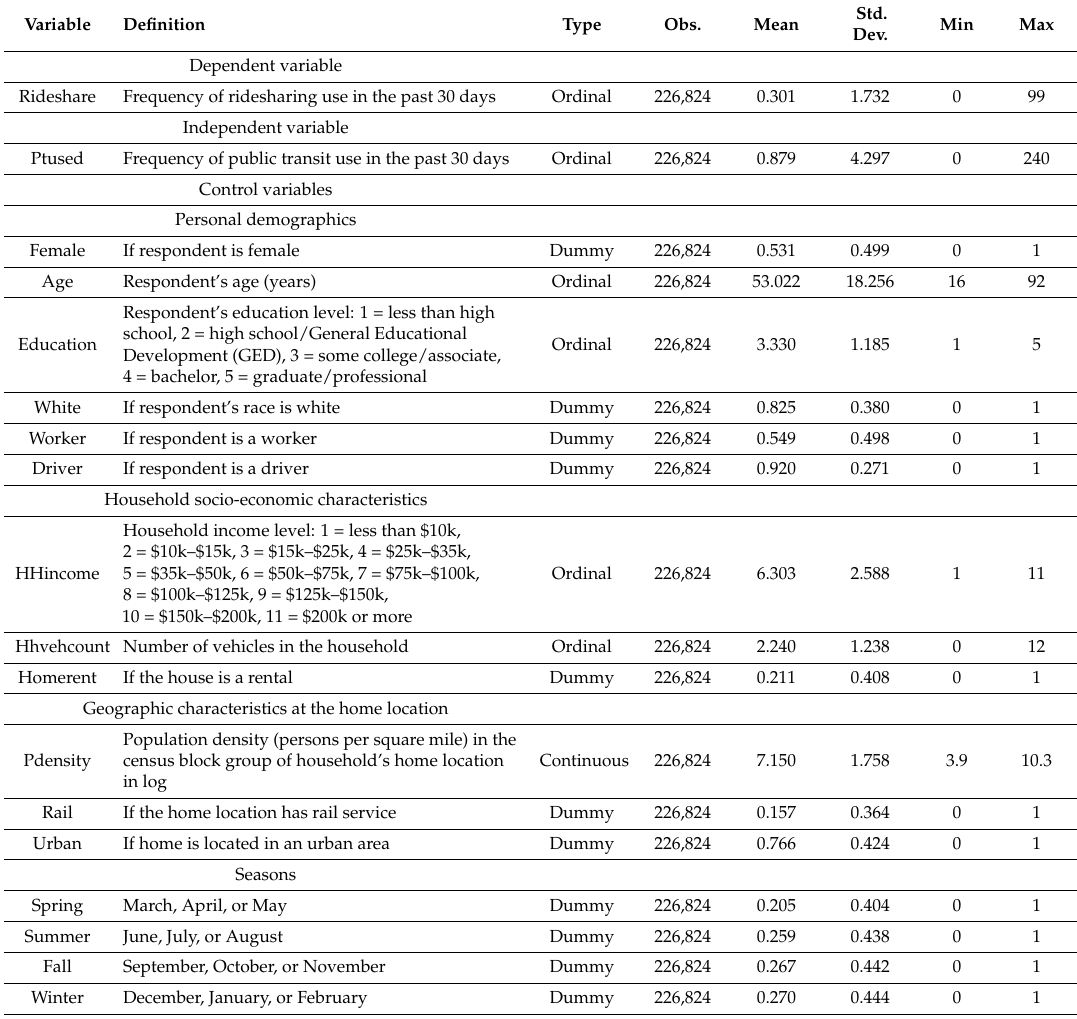
Table 1. Variable definitions and descriptive